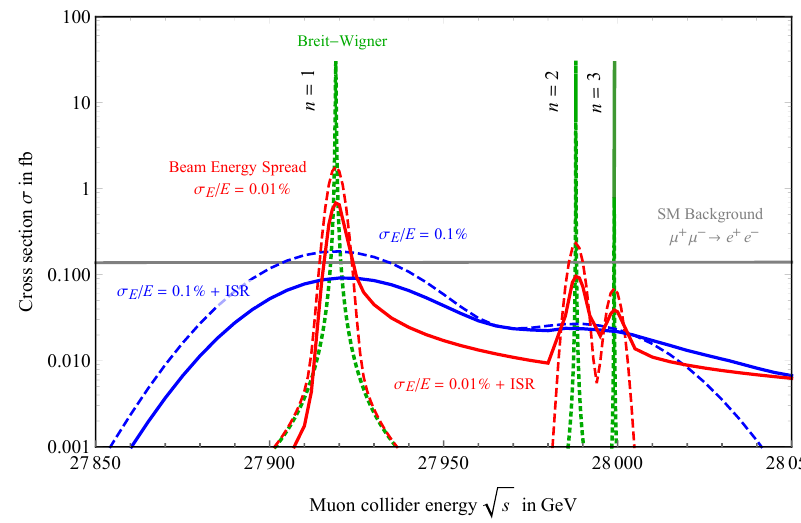
DM bound states with 1 = 10 − 3 E (baseline value) and σ = 10 − 4 E E E